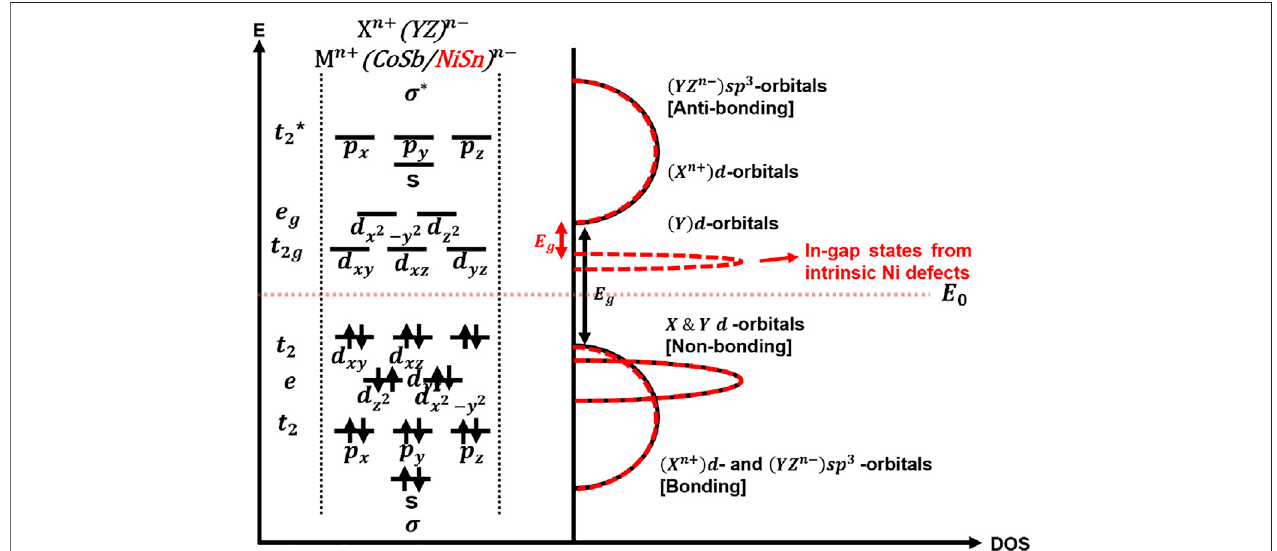
FIGURE 2 | MO diagram illustrating differences between MCoSb and